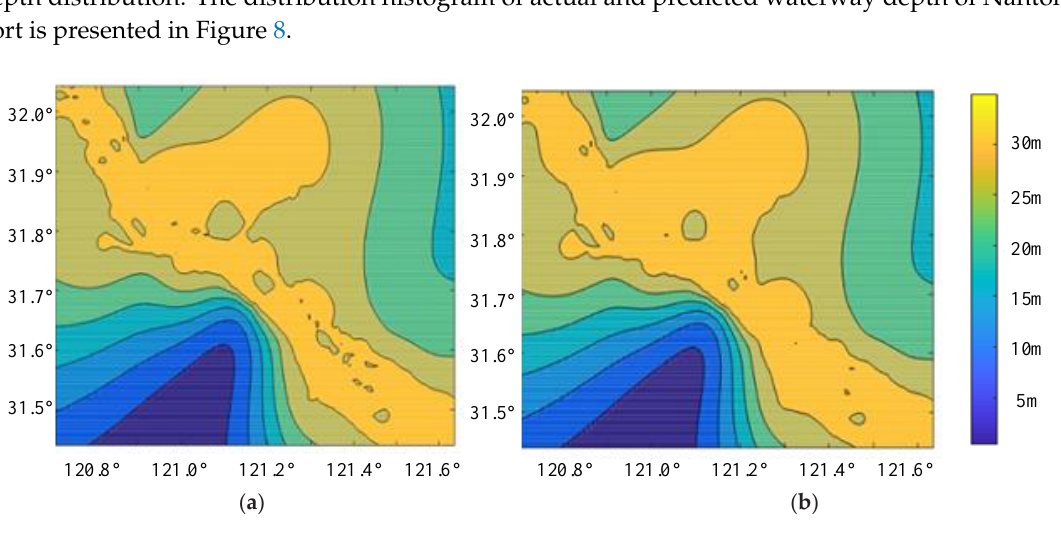
Figure 7. Comparison of the results of prediction of waterway depth for Nantong Port: ( a ) ground truth data, ( b ) predicted waterway depth.